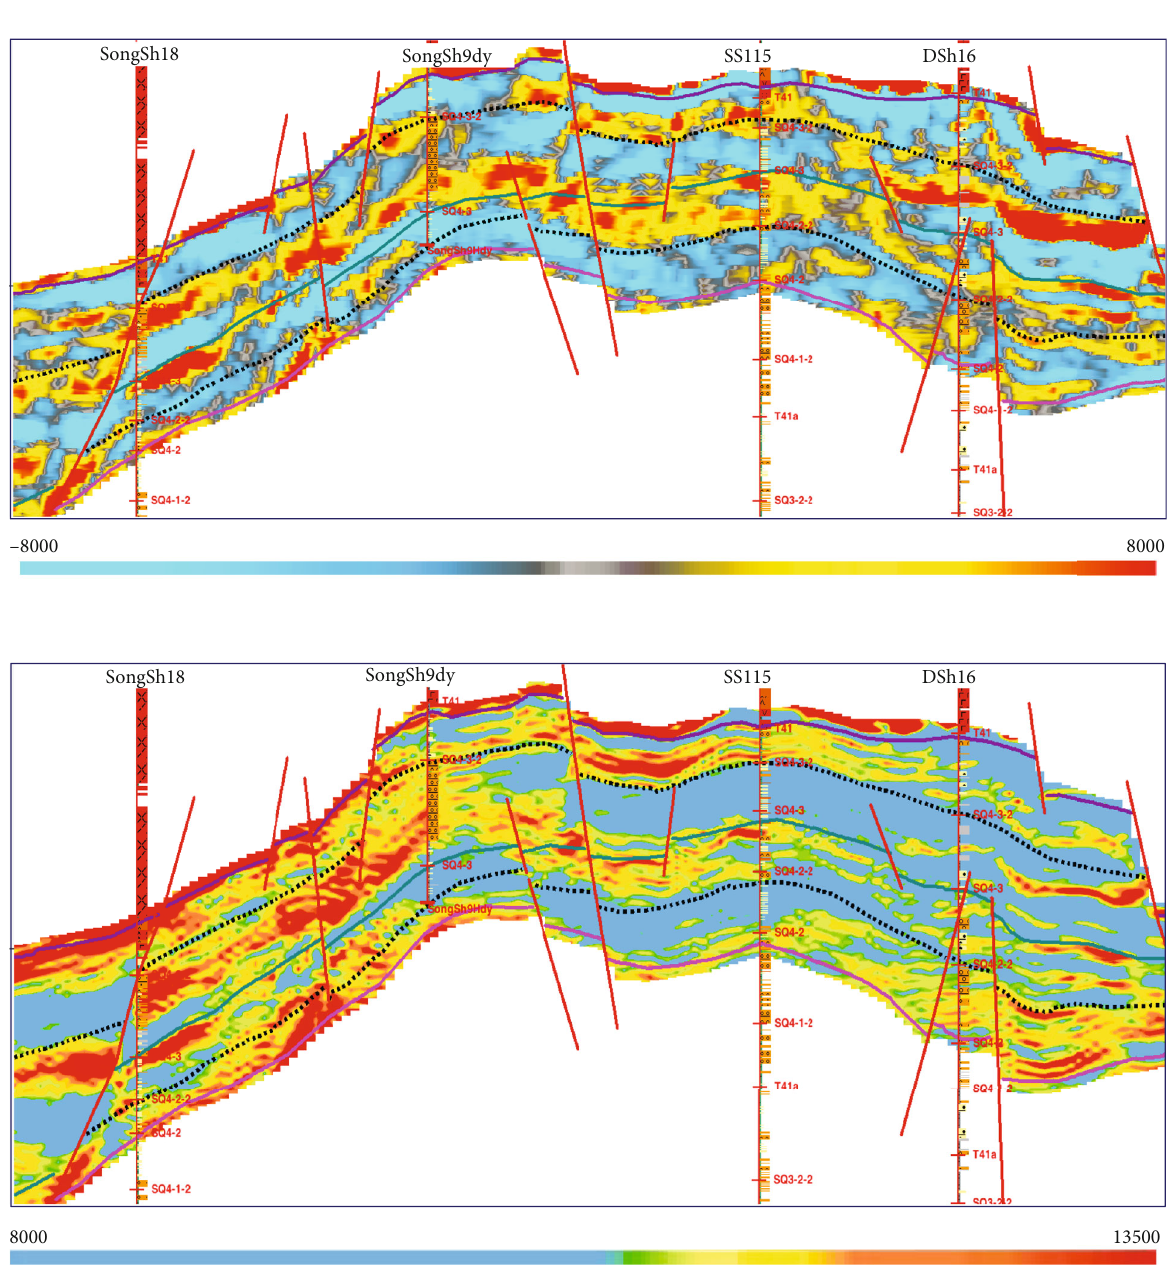
Figure 4: Comparison of P-wave impedance pro fi les of relative impedance (a) and phase controlled prestack inversion